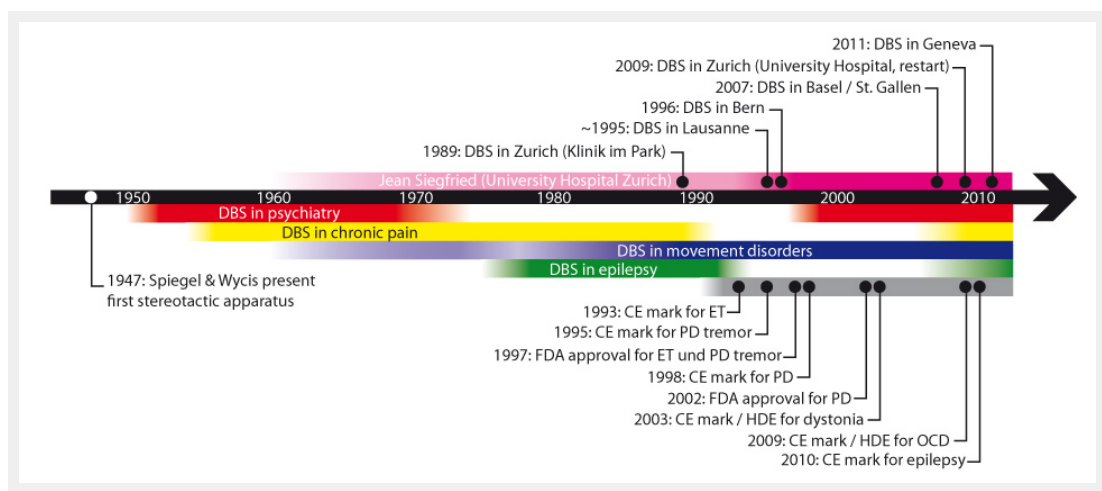
A schematic overview of the emergence of DBS summarising three historical reviews about the history of deep brain stimulation [1, 2, 4: chapter 2] demonstrates that almost all modern applications of DBS had precursors reaching back up to the 1950’s. The stereotactic frame introduced by Ernst Spiegel and Henry Wycis in 1947 set the technological precondition for precisely addressing targets deep in the brain. First, psychiatric applications have been discussed and implemented – but they also suffered the longest delay, probably due to the critique the experiments of José Delgado, Robert Heath and others have raised at that time. Pain (beginning in the late 1950’s, with a first culmination in the 1970’s; beside others: Mazars and Hosobuchi) and epilepsy (beginning in the late 1970; beside others: Cooper) experienced a first appreciation as diseases potentially suitable for DBS both before today’s re-emergence. DBS for addressing movement disorders had been experimentally approached already in the early 1960’s (beside others: Alberts and Albe-Fessard) and were, although on low profile, an ongoing issue within early DBS research before its modern re-emergence marked by the paper of Benabid et al. [38]. The chart also shows the dates of official approvals of Medtronic DBS-systems either by the European CE mark or by the Food and Drug Administration (FDA) of the United States (data: Regina